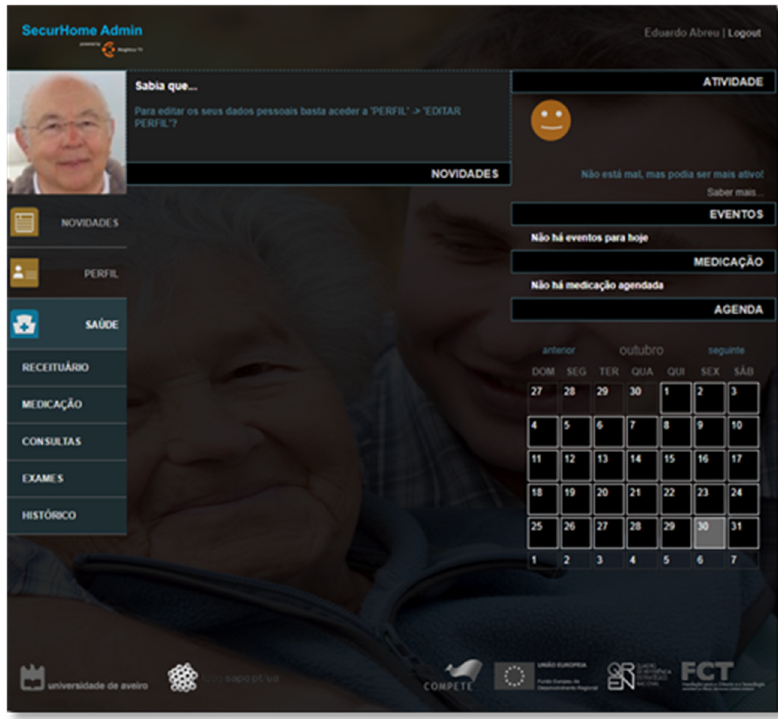
Figure 17. Health area of SecurHome Admin application.